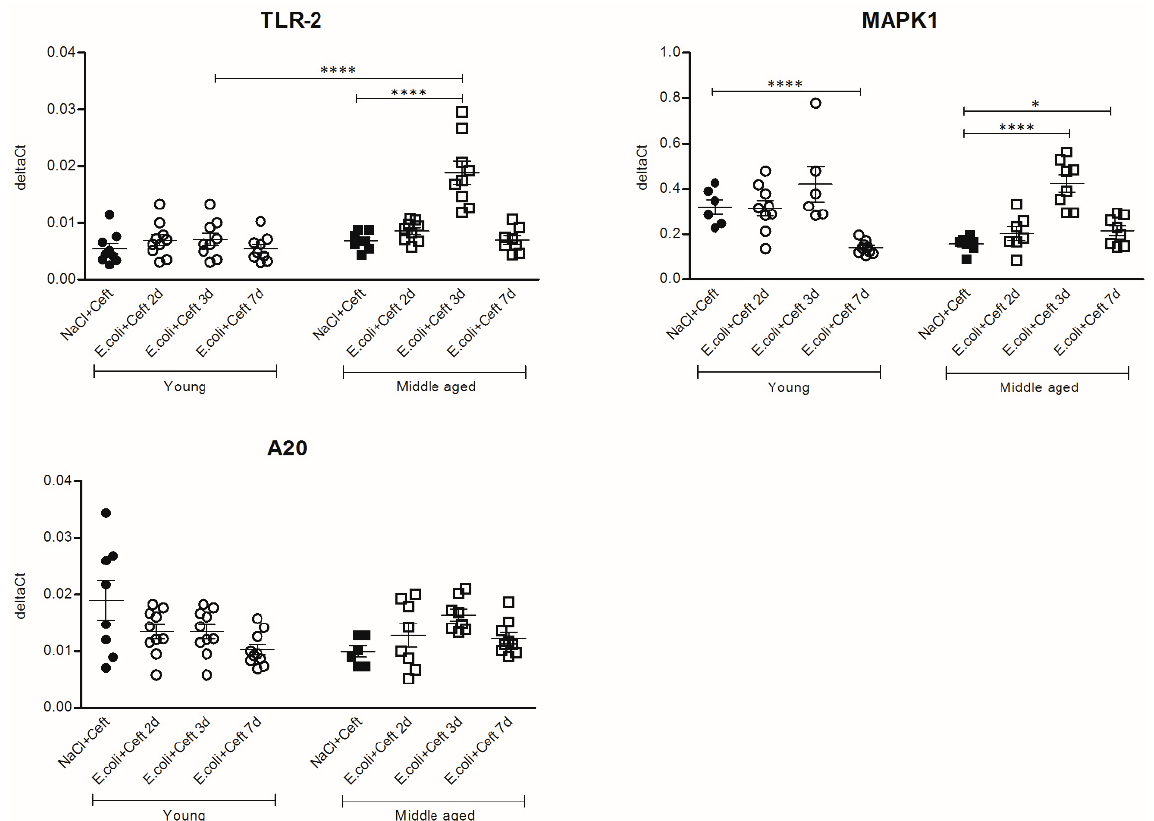
Figure 9. mRNA expression of brain homogenate of components of the TLR signaling cascade: TLR-2, MAKP1 and A20, illustrated in deltaCts. Group size varies from n = 8 to 10. Parametric or non-parametric two-way ANOVA (factors: age and time point) were conducted and continuous variables were tested with post-hoc Mann–Whitney U tests or Student t -tests, depending on the distribution of the data. For non-parametric ANOVAs, ranked transformation of the data was performed. Data represent mean ± SEM, * p ≤ 0.05, **** p ≤ 0.0001.